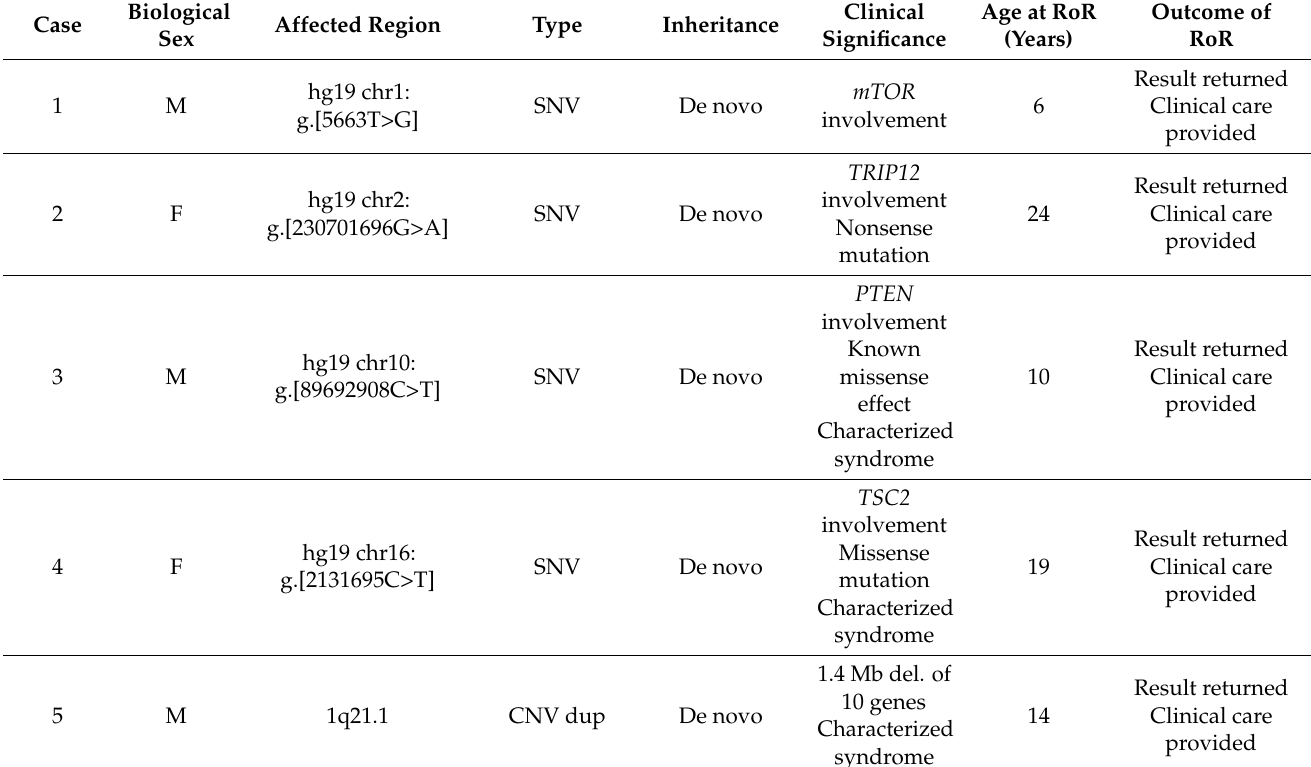
Table 2. Characteristics and genetic findings of participants for whom a genetic research result was available. Case